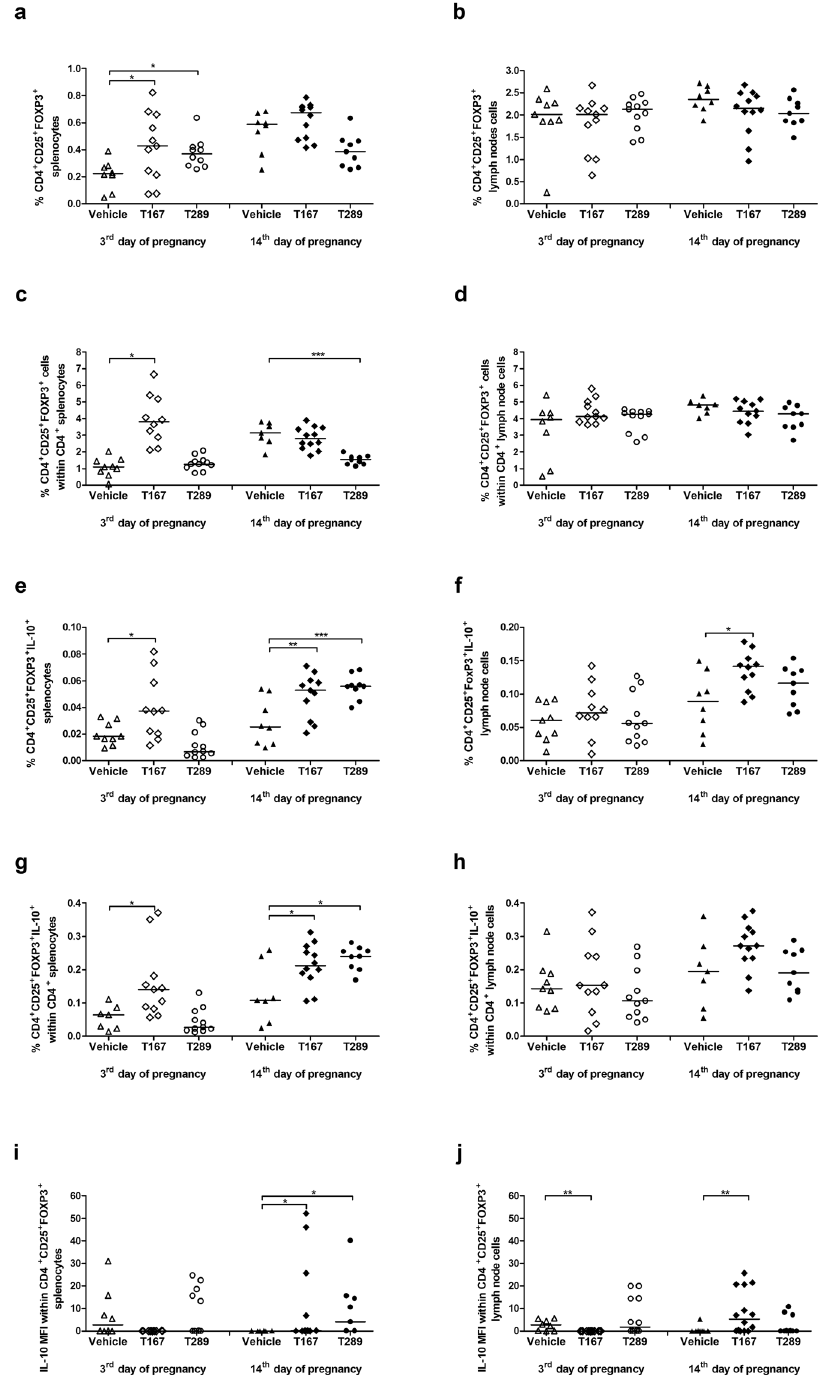
Figure 3. Effect of tregitope treatment on regulatory T lymphocytes in a murine abortion-prone pregnancy model. Cells were stimulated with PMA and ionomycin in the presence of brefeldin A and monensin and the frequencies of CD4 + CD25 + Foxp3 + (a) splenocytes and (b) uterine-draining lymph node cells within CD4 + (c) splenocytes and (d) lymph node cells and the frequencies of CD4 + CD25 + FOXP3 + IL-10 + splenocytes (e) and (f) lymph node cells within CD4 + (g) splenocytes and (h) lymph nodes and the median fluorescence intensity (MFI) of IL-10 within CD4 + CD25 + FOXP3 + (i) splenocytes and (j) uterine-draining lymph node cells were measured. The data were analysed by one-way ANOVA (normal distribution) or the Kruskal-Wallis test (non- normal distribution) with Dunn’s multiple comparison post hoc test (P < 0.05) and are presented as individual values with median (at 14dpc n = 12 for T167, n = 9 for T289, n = 9 for Vehicle; at 3dpc n = 11 for T167, n = 11 for T289, n = 9 for Vehicle). * P < 0.05, ** P < 0.01, and *** P <